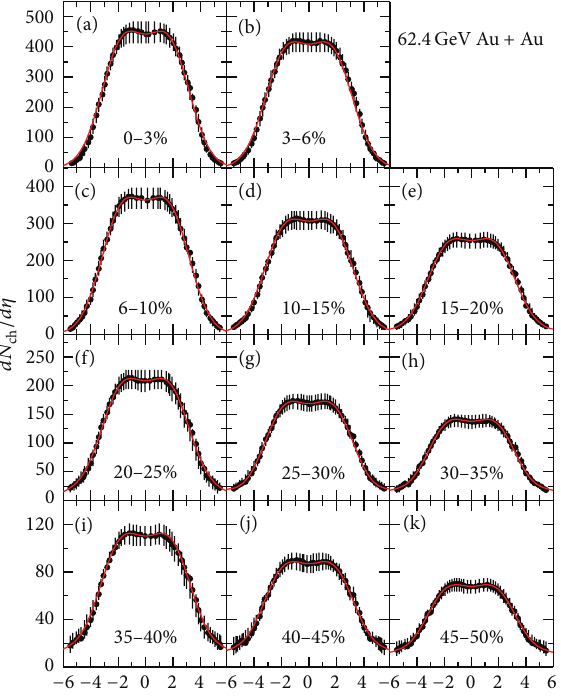
Figure 2: As Figure 1 but showing the results in Au-Au collisions at √𝑠 = 62.4 𝑁𝑁